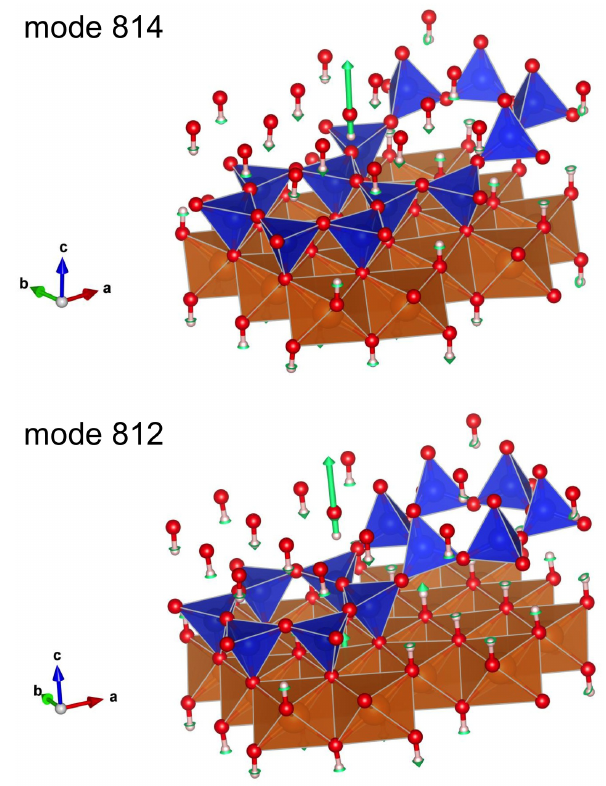
Figure 7. Views of the atomic displacements in the localized OH stretching modes associated with the 8-reversals (green arrows whose length is proportional to the magnitude of atomic displace- ment). Corresponding Vesta files are reported as supplementary in- formation. The modes 812 and 814 contribute to the theoretical bands at 3649 and 3665cm − 1 , respectively. They are related to the modes 813 and 815, respectively, by the pseudo 2-fold axis corre- sponding to the